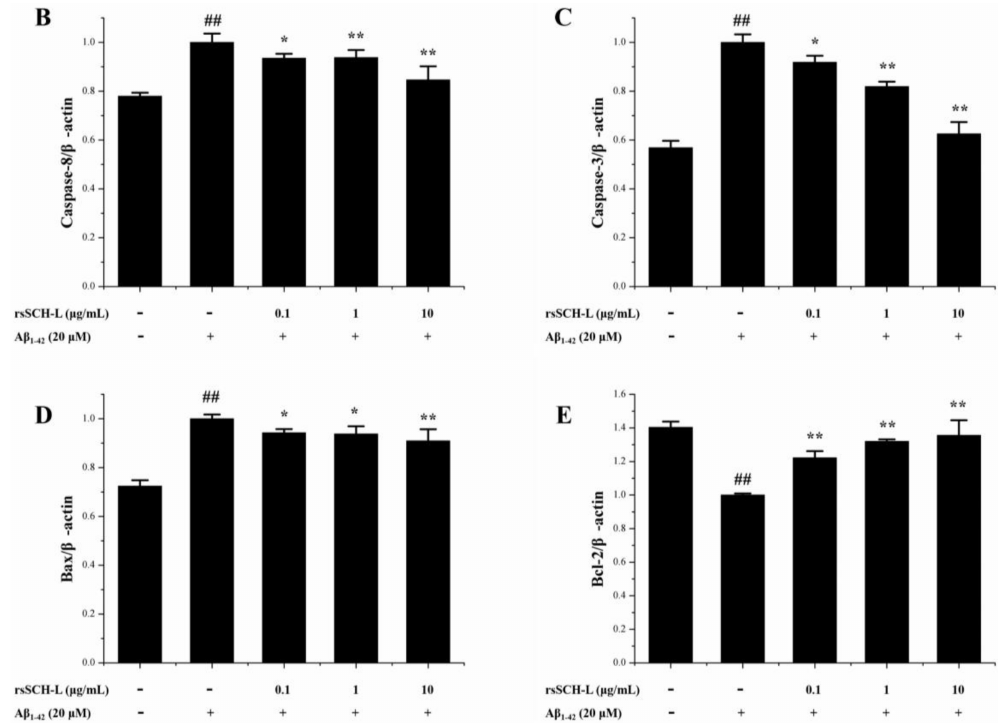
Figure 6. Effects of rsSCH-L on the expressions of Caspase-8, Caspase-3, Bax, and Bcl-2 proteins in neuronal cells. ( A ) Caspase-8, Caspase-3, Bax, and Bcl-2 protein expressions, ( B ) Caspase-8 protein level in neuronal cells, ( C ) Caspase-3 protein level in neuronal cells, ( D ) Bax protein level in neuronal cells, and ( E ) Bcl-2 protein level in neuronal cells. ## p < 0.01 vs. control group, * p < 0.05, ** p < 0.01 vs. A β 1-42